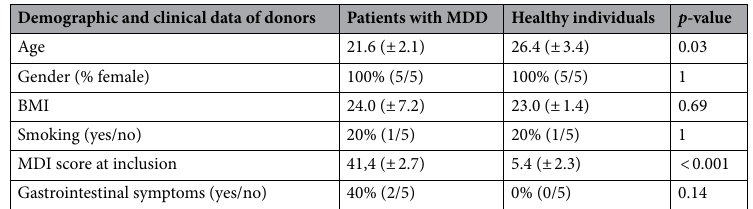
Table 1. Demographic and clinical data on human participants. Data displays the age, gender, BMI and smoking status of either patients with MDD or healthy individuals. Depressive severity was scored using the